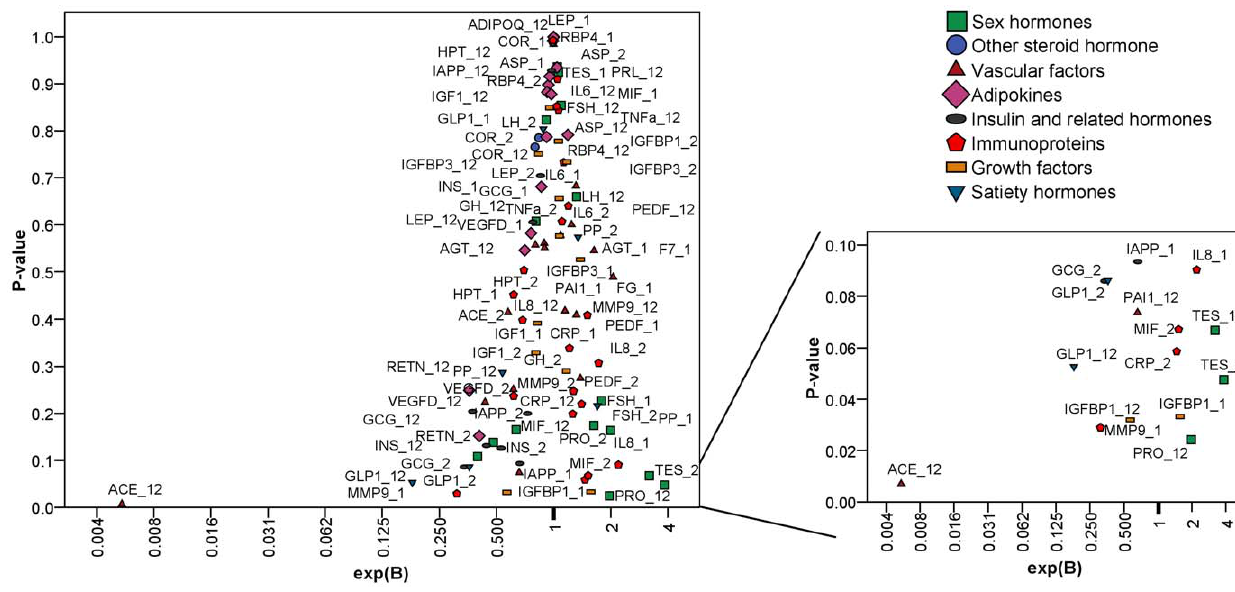
Figure 1. The predicting power of blood analytes for weight loss maintenance by Logistic Regression. Volcano plot of the significance P-value versus odd ratio exp(B) of blood proteins/steroids for predicting continued weight loss during the 6-month maintenance period by logistic regression controlled for age and the fold change of weight. The symbols of the analytes are listed in Table 1. Suffix ‘‘_1’’: concentration at CID1, ‘‘_2’’: concentration at CID2, ‘‘_12’’: the fold change of concentration CID2/CID1. The analytes are grouped as in Table 1 and marked in different shape/ color.